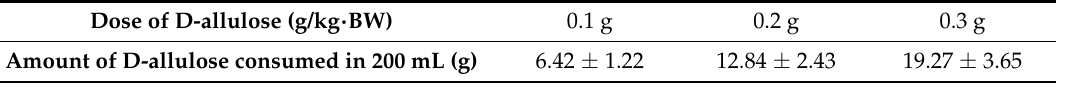
Table 2. Dose of D-allulose included in the test drinks for regular ingestion. Dose of D-allulose (g/kg · BW) 0.1 g